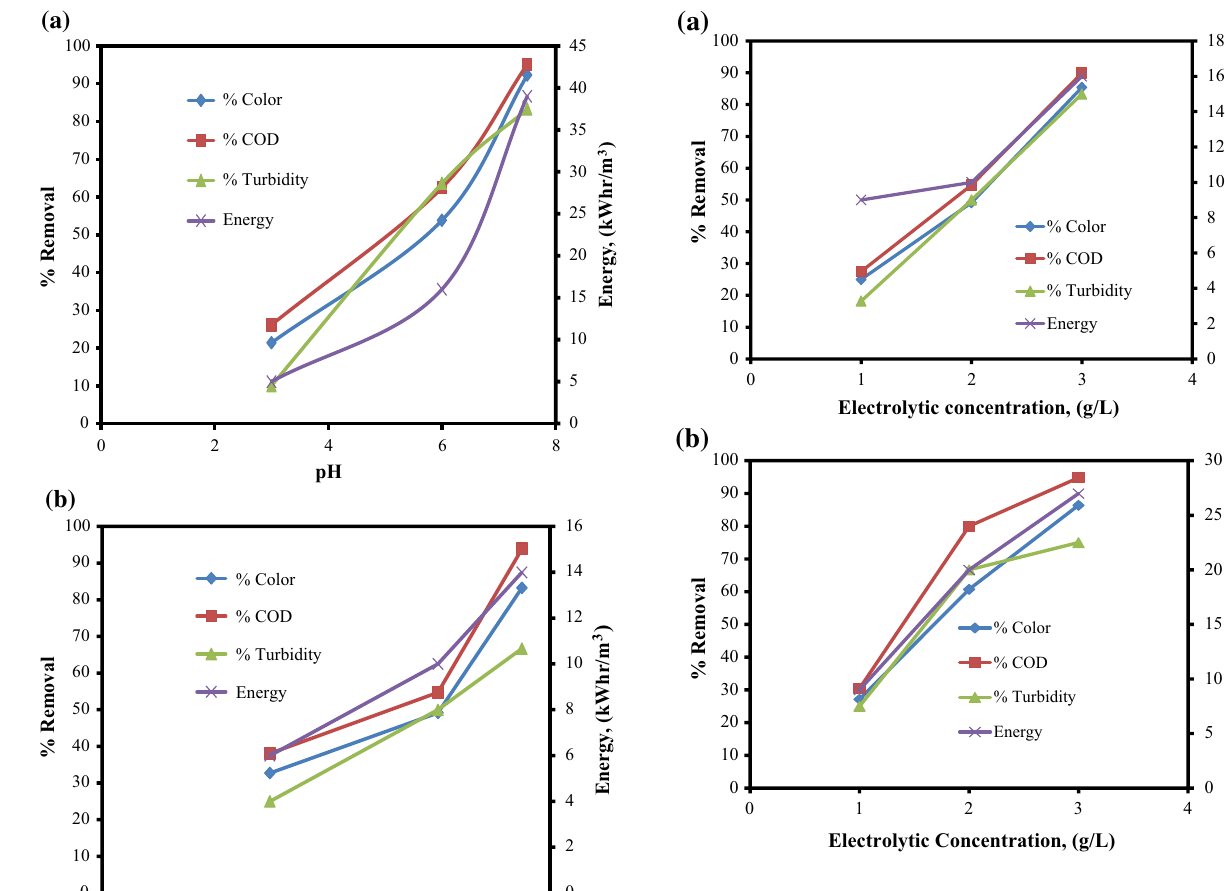
Fig. 3 Removal efficiency and power consumption versus electrolytic concentration on a Al and b